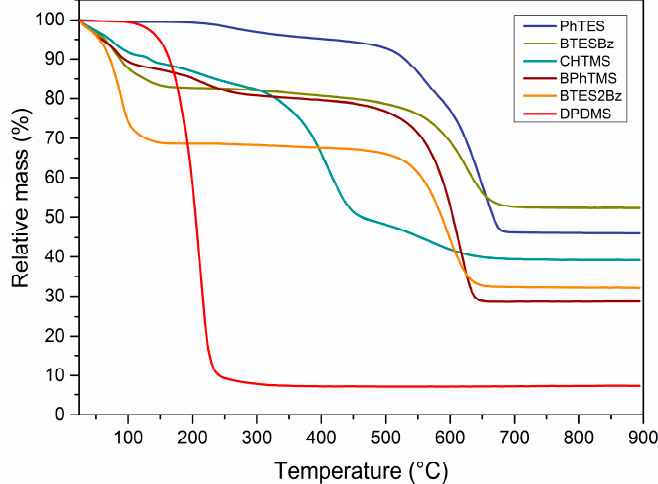
Figure 4. Thermal evolution of different organosilica materials. Thermogravimetric analysis (TGA) of materials derived from PhTMS, BPhTES, CHTMS, BTESBz, BTES2Bz and DPDMS in flowing air. Heating rate of 5 °C/min.